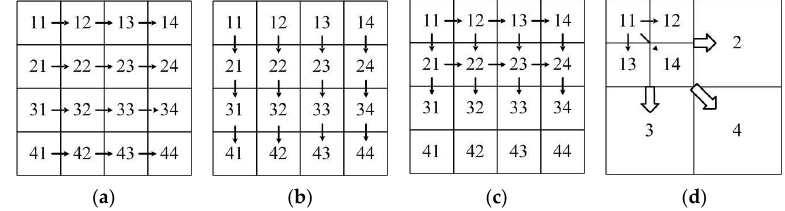
Figure 1. Schematic diagram of the sequence of image adjustment: ( a ) left image benchmark; ( b ) above image benchmark; ( c ) left image cross; and ( d ) quadtree.